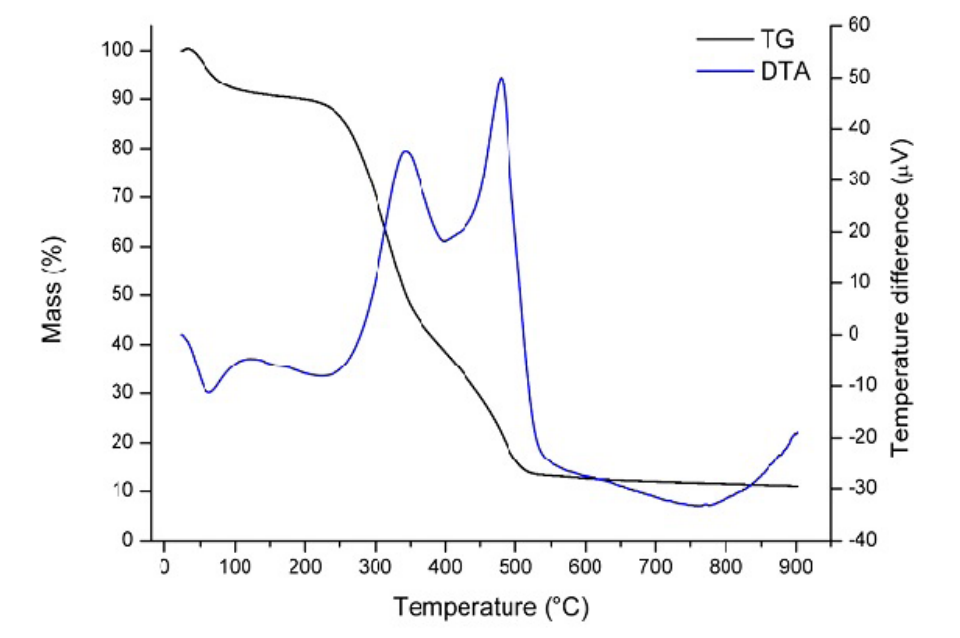
FIGURE 1 – Thermogravimetric curve and differential thermal analysis of vegetal drug from T. inamoema